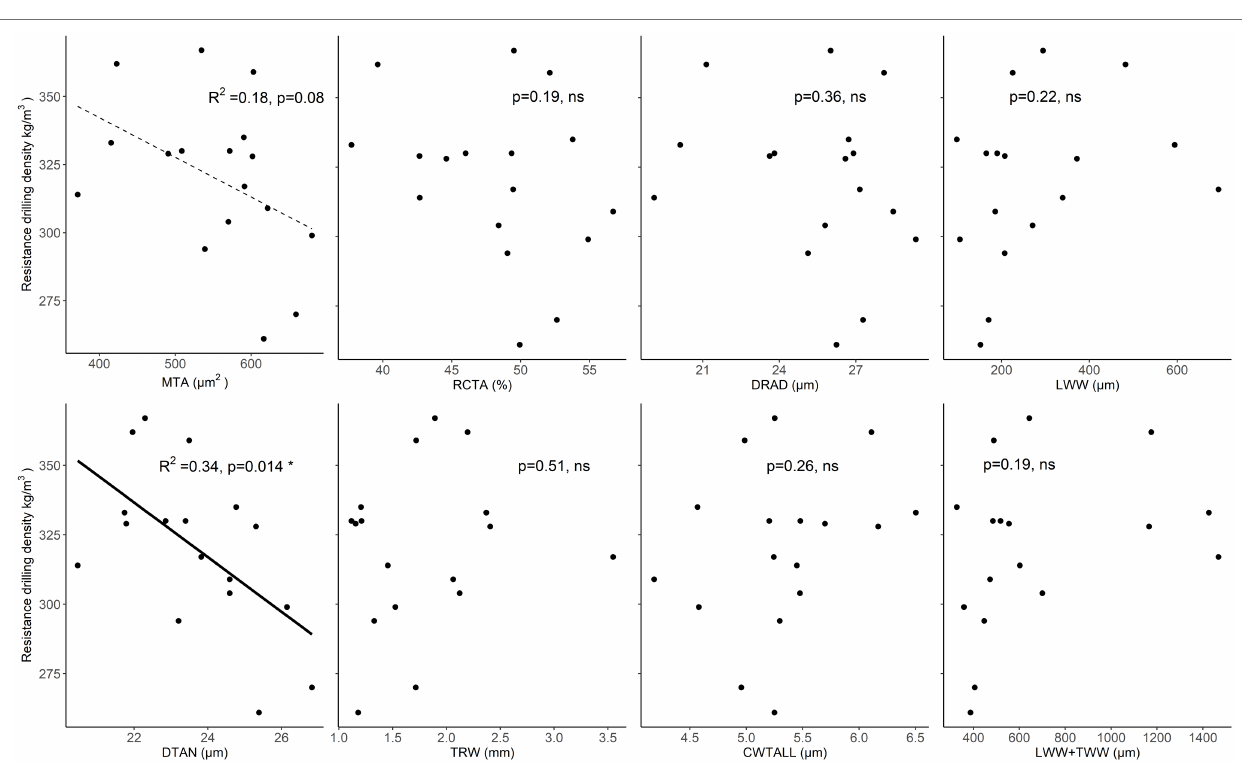
FIGURE 6 | Relationships between resistance drilling density values and wood-anatomical features (MLA—mean lumen area, RCTA—relative conducting area, DRAD—radial lumen diameter, LWW—latewood width, DTAN—tangential lumen diameter, TRW—tree-ring width, CWTALL—mean tracheid wall thickness, and TWW + LWW—the total width of transition wood and latewood) in spruce. Weak relationships ( p < 0.1) between wood-anatomical features and resistance drilling density are marked with a dotted line, while significant relationships ( p < 0.05) are shown by a full line. Further statistical information for the presented linear models is given in Supplementary Table 4